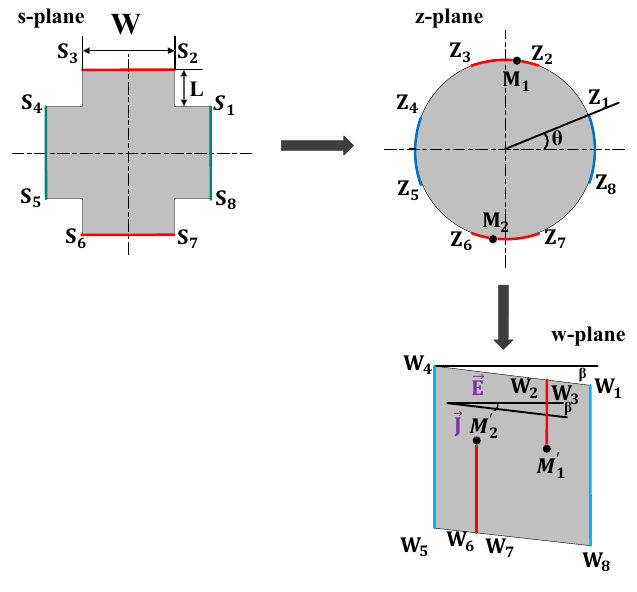
Figure 2. Schematic of the calculation procedure of G . Table 1. Mapping parameters from the unit disk to rhomboidal